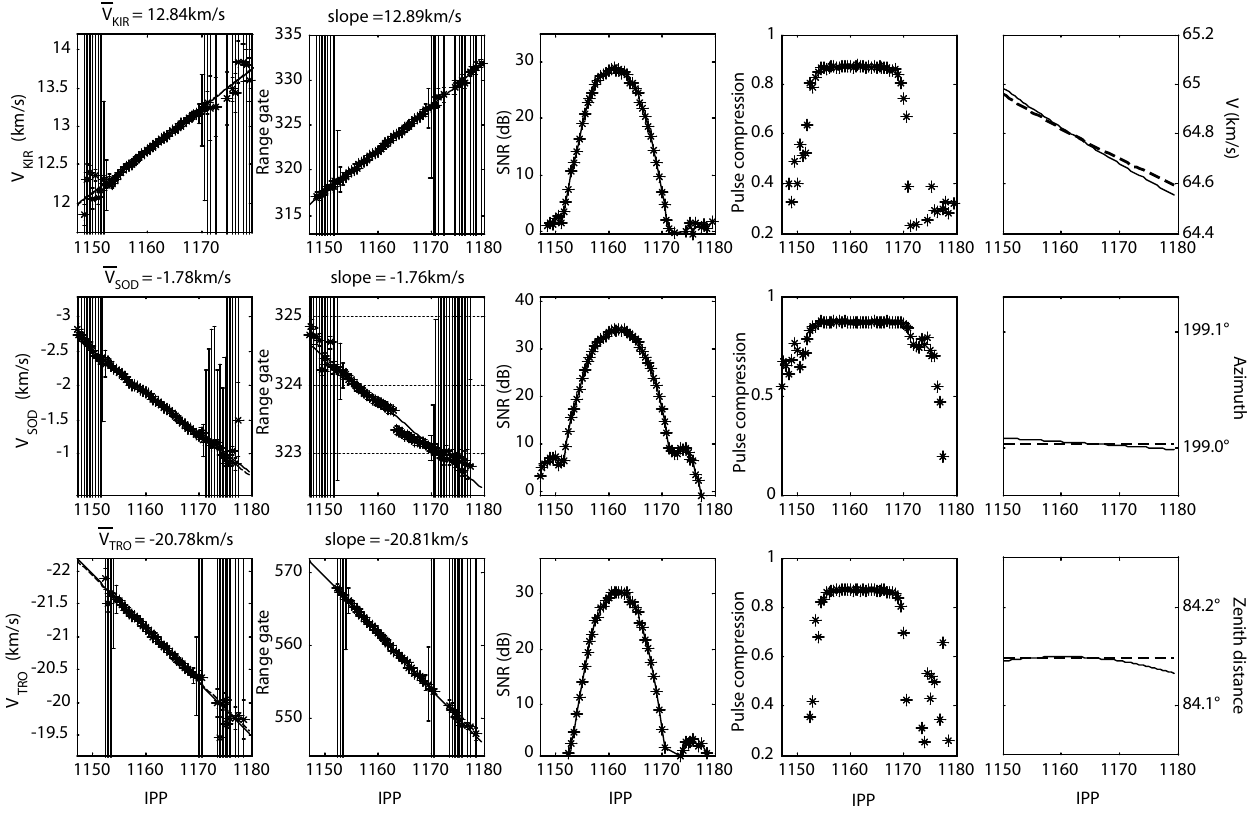
Fig. 3. Doppler velocity (column 1), range gate (column 2), SNR (column 3), and pulse compression (column 4) versus IPP as seen from Kiruna (row 1), Sodankyl¨a (row 2), and Tromsø (row 3). The rightmost column shows meteoroid velocity (top) azimuth (middle) and zenith distance (bottom) on the ordinates and IPP on the abscissae. The solid lines present the values found when combining the least-squares fitted values of Doppler velocity and range from all receivers. The dashed lines indicate the values found when assuming a straight trajectory. The values given in the subplot headers are the weighted arithmetic mean of the Doppler velocities (column 1) and the slopes of the linear curves fitted to the range data (column 2).